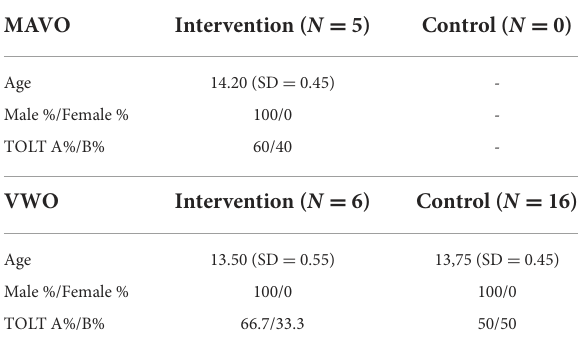
TABLE 1 Characteristics of